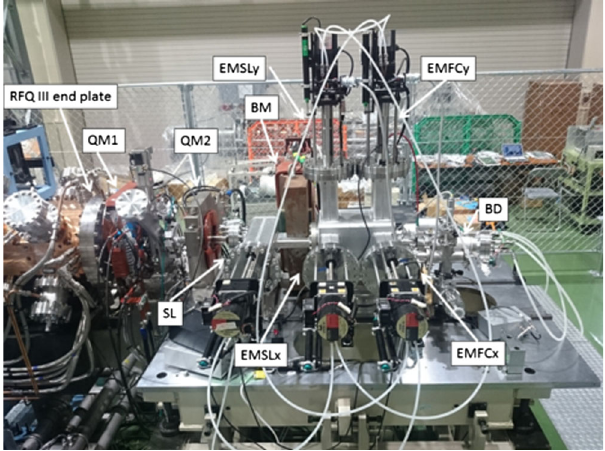
FIG. 3. Photograph of the test bench.